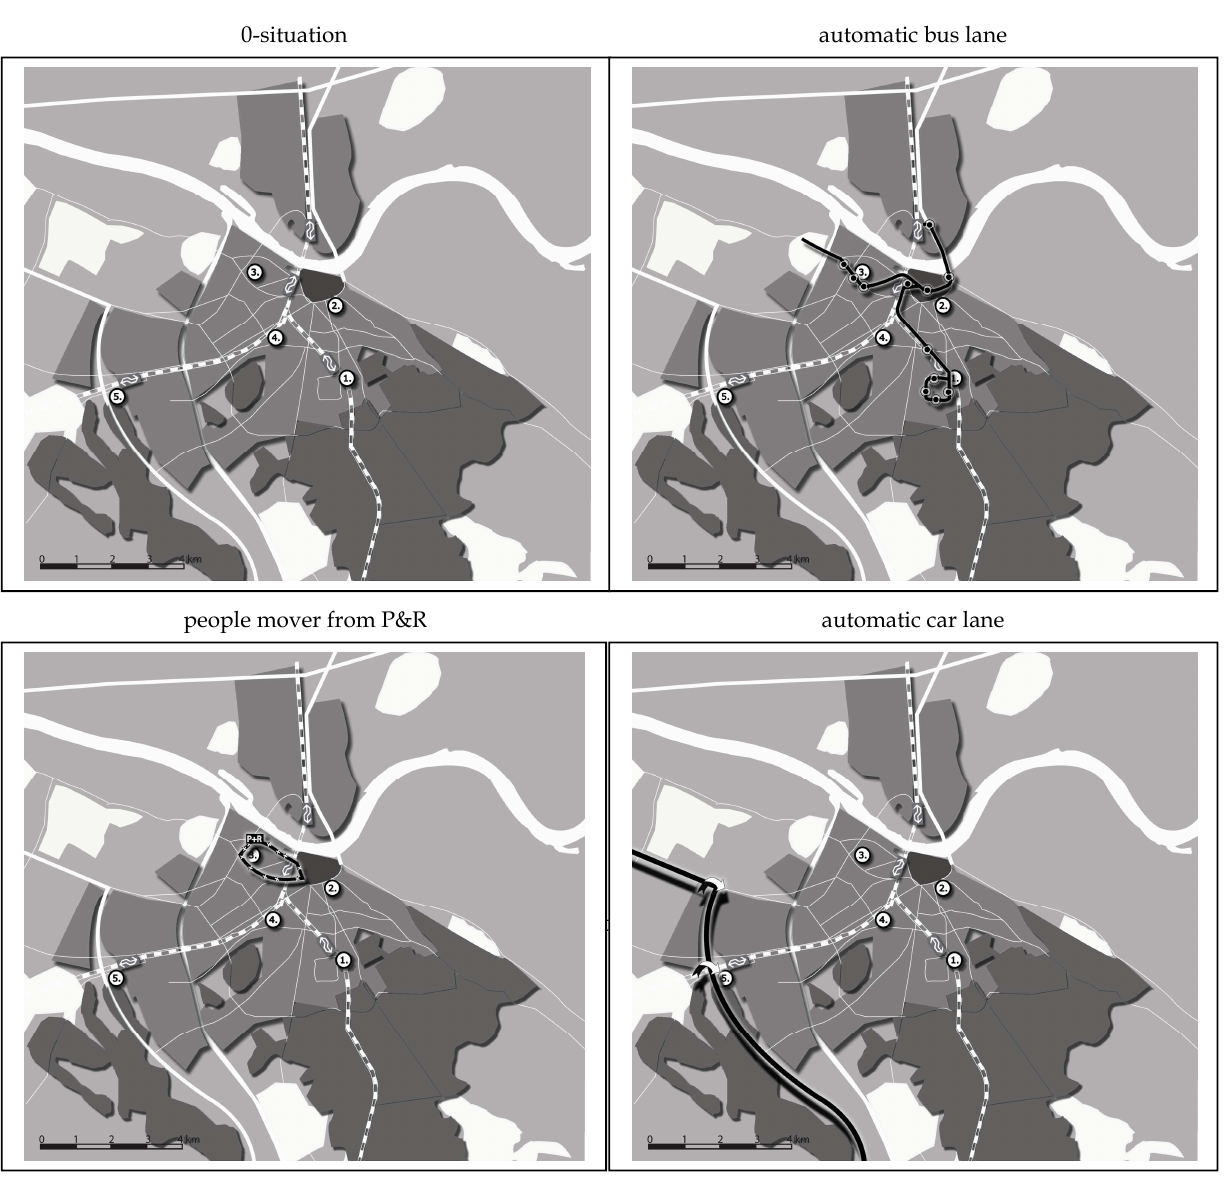
Figure 1. ITS scenarios visualized for the city of